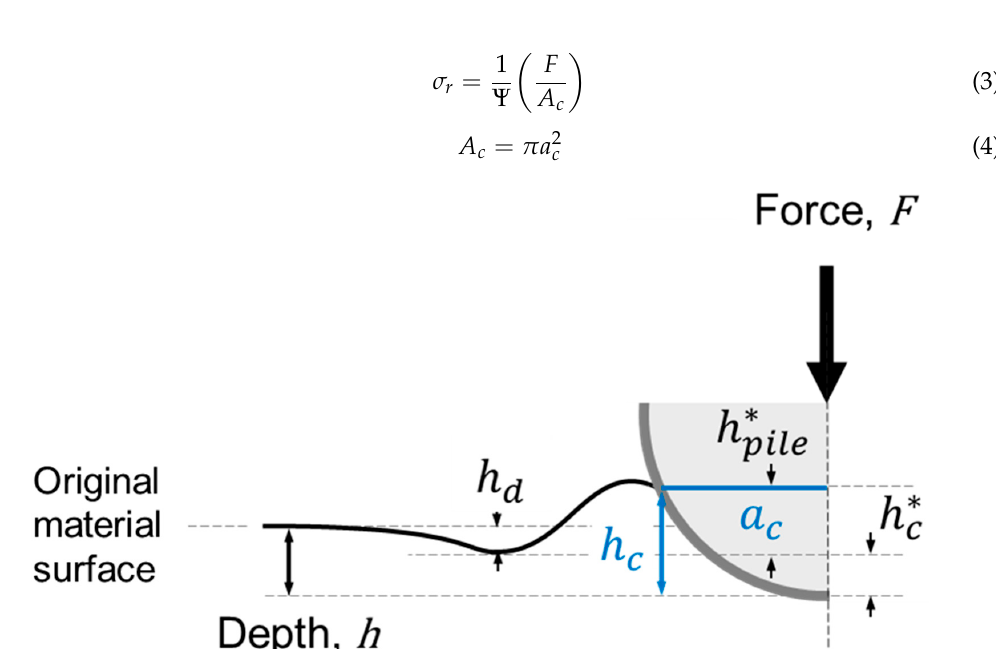
Figure 3. Schematic representation of a spherical indentation test and basic nomenclature; contact radius, a c , and contact depth, h c , highlighted in blue for clarity.